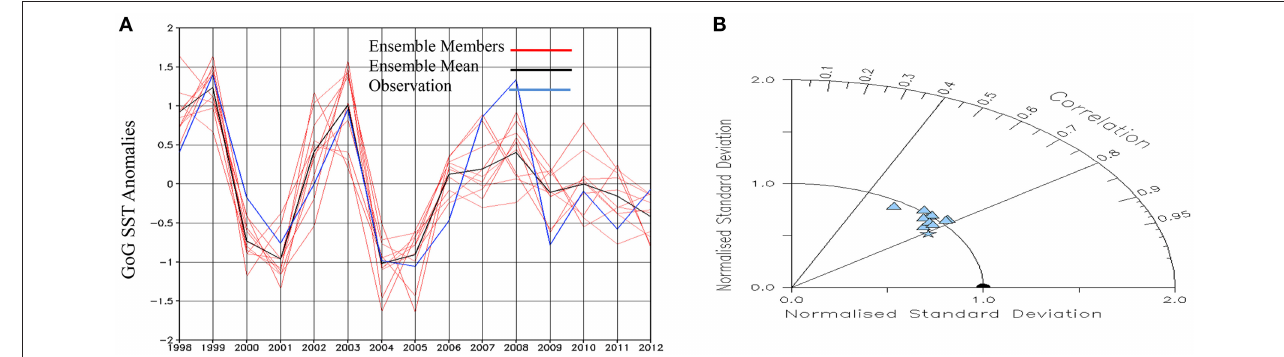
FIGURE 3 | Inter-annual variability of standardized SST anomaly over (A) the Gulf of Guinea by the ensemble members (red-lines), the ensemble mean(black-line) and observed Era-Interim (blue-line); (B) Taylor diagram showing the normalized standard deviations and the correlation coefficients of S2S ensemble simulations with observation for panel a (ensemble members—blue triangle; blue circle for negative correlations), ensemble mean—blue star and Era-Interim (observation)—black semi-circle. The normalized standard deviations and correlations are with reference to Era-Interim over same